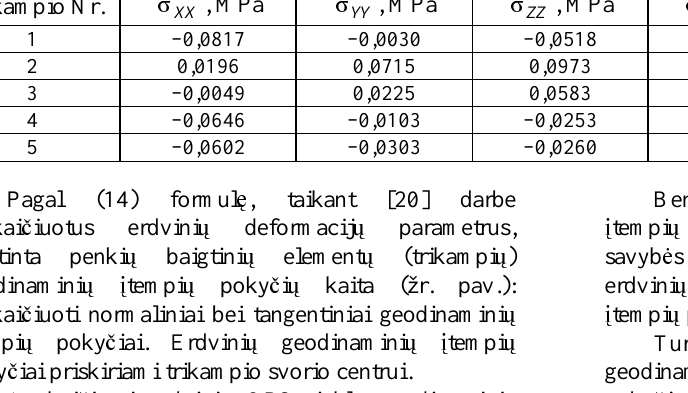
Table 3. Changes of geodynamic stresses Trikampio